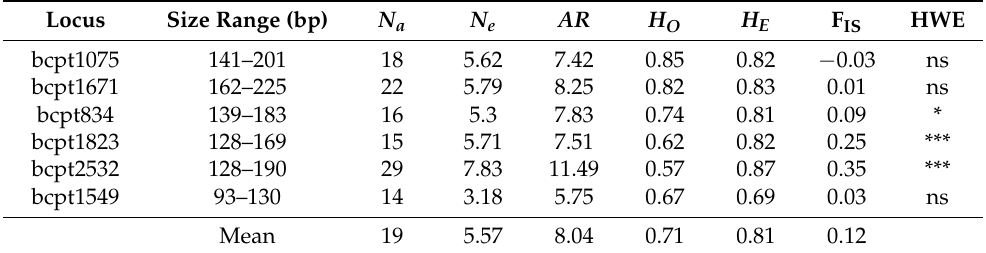
Table 2. Genetic diversity of the Iki-no-Matsubara P. thunbergii population using six primer markers. Locus Size Range (bp) N a N e AR H O H E F IS HWE